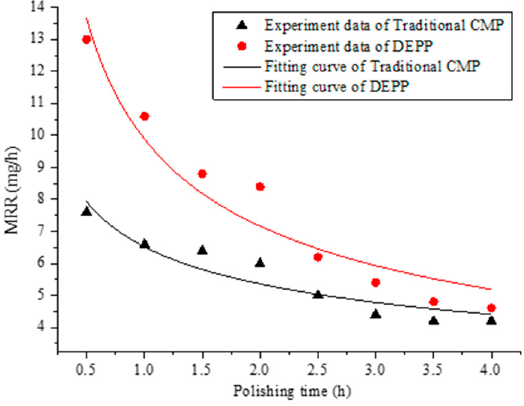
Figure 14. MRR comparison between traditional CMP and DEPP.